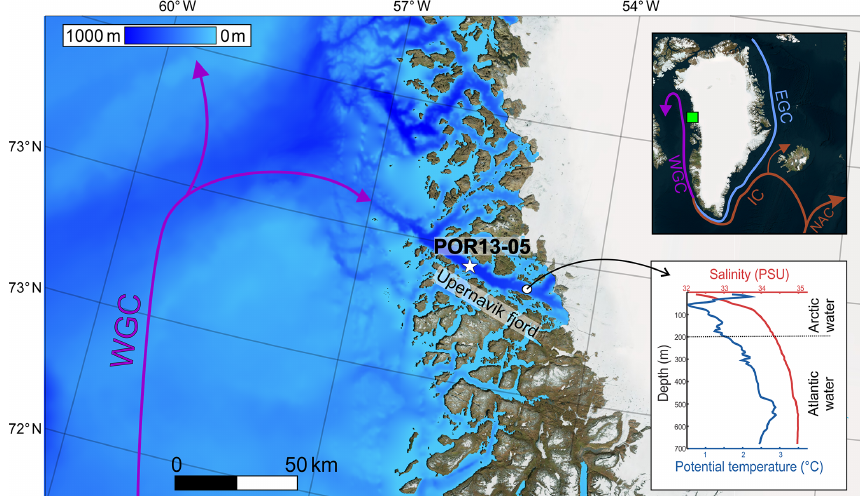
Figure 1. Position of core site POR13-05 (star) in Upernavik Fjord together with the surrounding bathymetry (Morlighem et al., 2017). The inset figure indicates the ocean currents around Greenland (Bing satellite map, 2017). IC is the Irminger Current, EGC is the East Greenland Current, WGC is the West Greenland Current, NAC is the North Atlantic Current, and FB is Fylla Banke. The green box in the inset marks the position of Upernavik Fjord and the light blue circle marks the position Fylla Banke. The CTD profile is from Andresen et al.